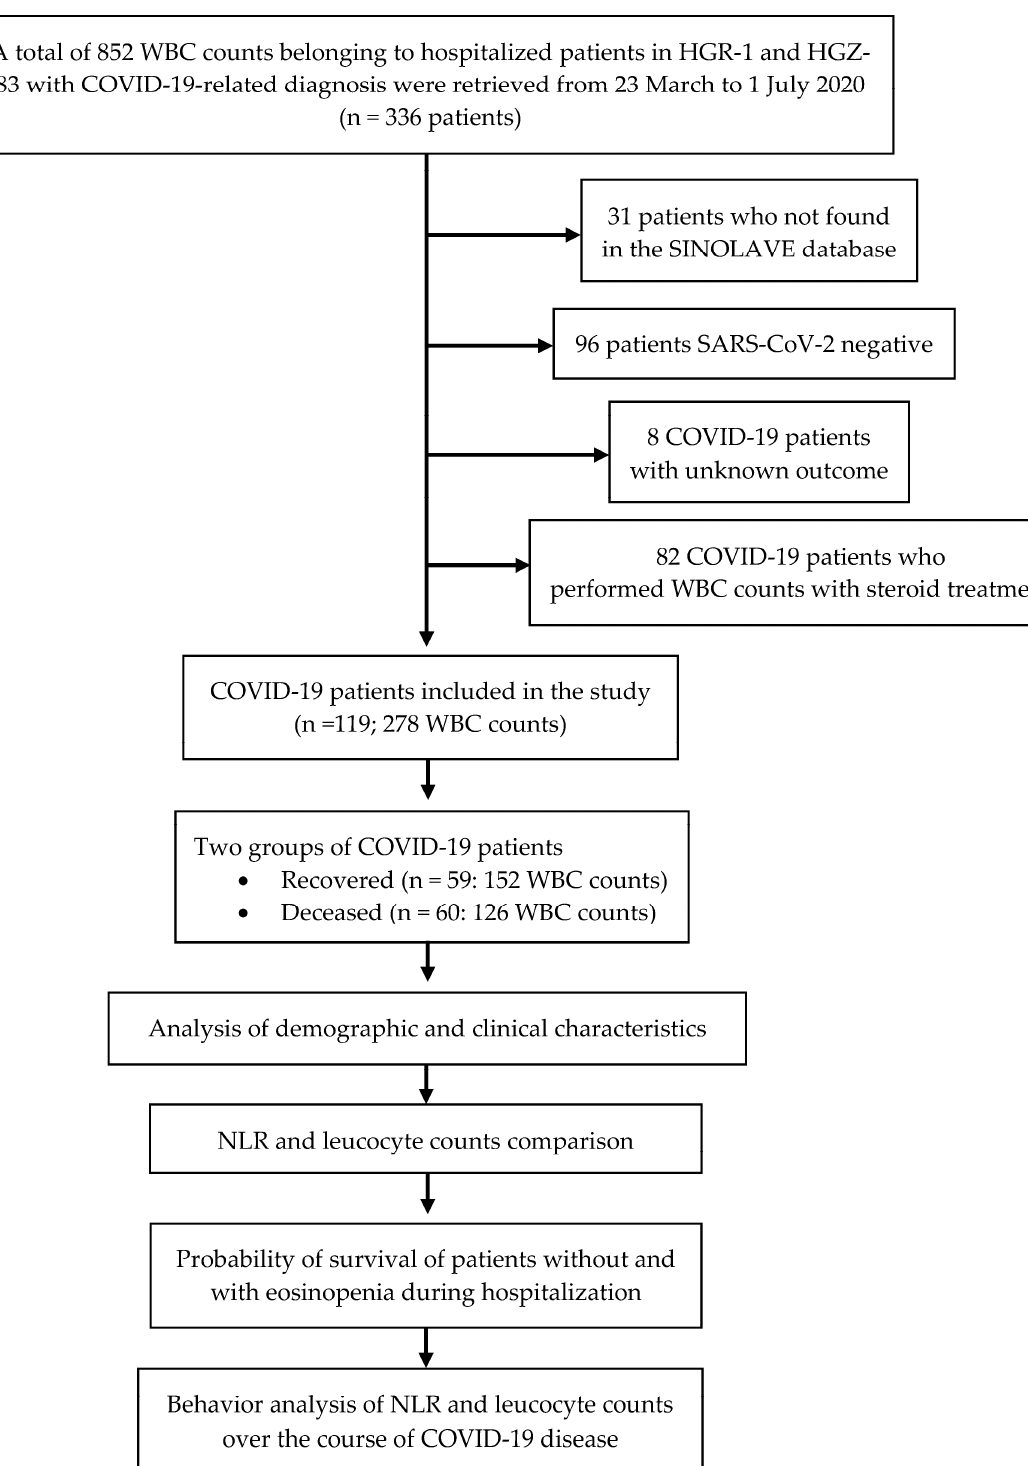
Figure 1. Study flowchart. white blood cell (WBC); Regional General Hospital l (HGR-1); General Hospital of Area 83 (HGZ-83); online notification system for epidemiological surveillance (SINOLAVE); neutrophil-to-lymphocyte ratio (NLR).